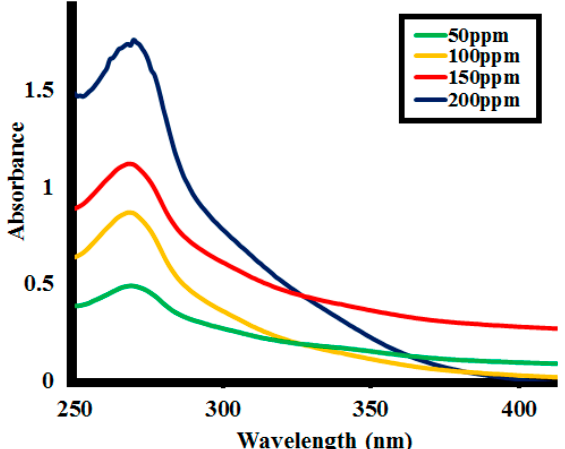
Figure 11. Photocatalytic depolymerization of the different lignin concentrations by 0.1 g SK9 after 60 min of catalytic activity. Table 4. %Depolymerization of the different lignin concentrations by SK9 (0.1 g) at the different time intervals.